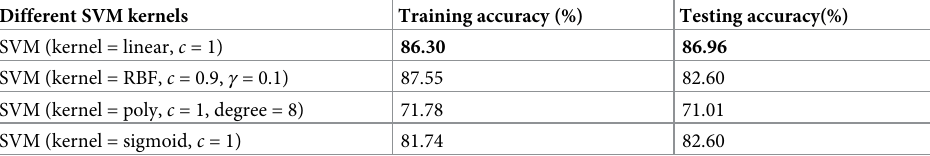
Table 5. SVM with different kernels using 6 features.